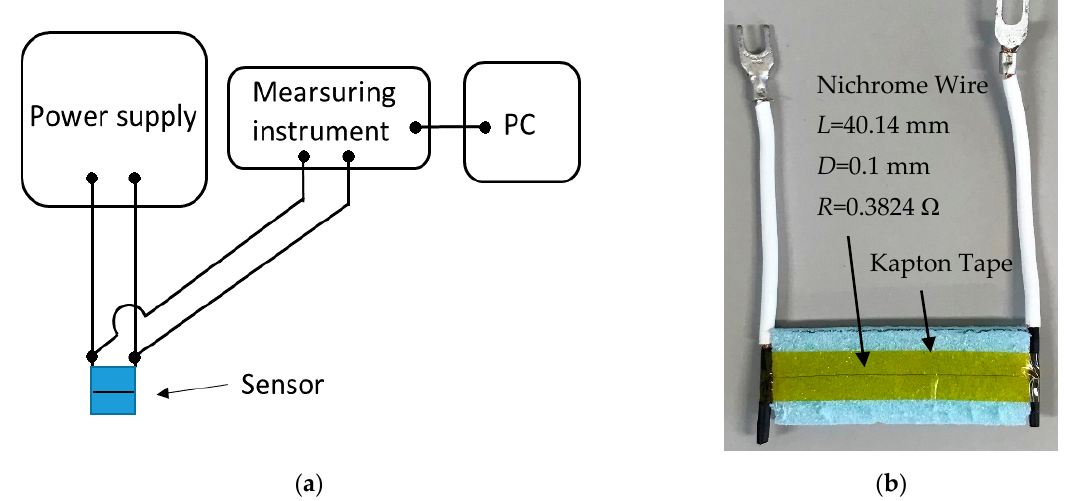
Figure 7. Thermal conductivity measuring device ( a ) Schematic Diagram ( b ) Sensor Unit.